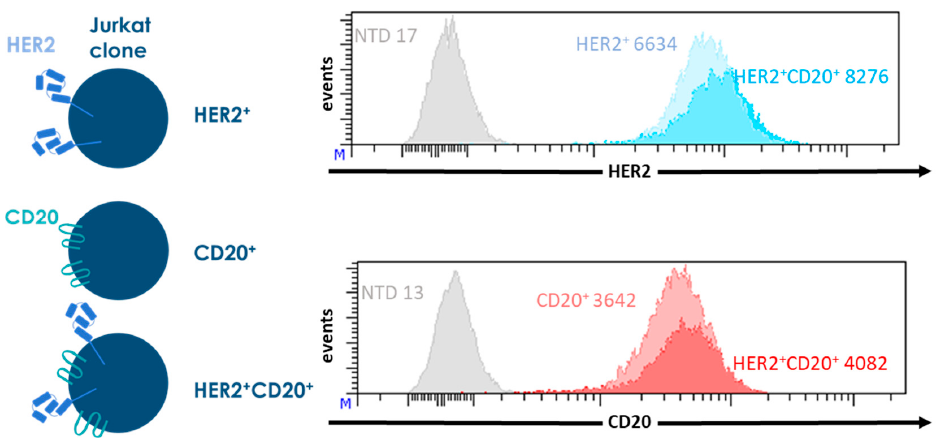
Figure 2. Characterization of the transgenic Jurkat lines expressing CD20, HER2, or both, that are used as target cells in the experiments shown in Figure 3. Jurkat cells were retrovirally transduced with the sequences coding for CD20 of for HER2 truncated at position 695 (HER2 Δ 695). The transgenic Jurkat cells were stained for CD20 and HER2 expression and analyzed by flowcytometry. As antigen negative control, non-transduced Jurkat cells (NTD) were used, MFIs are shown for each Jurkat clone.